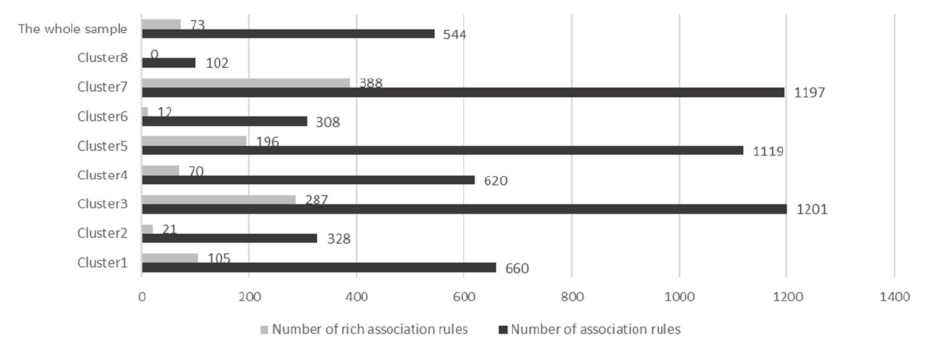
Figure 11. Function associate rules of the